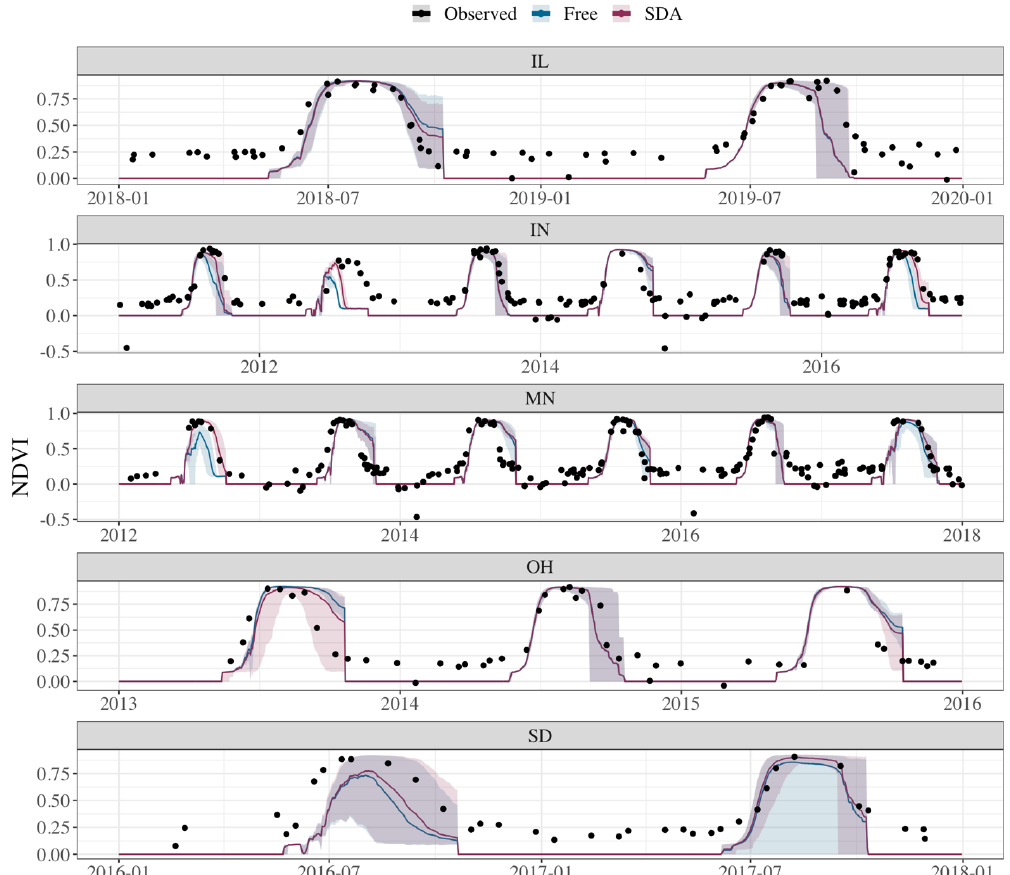
Figure A2. Time series of NDVI estimates from the two schemes for each site year with the mean daily estimates demonstrated with line graphs and the 95% credibility interval demonstrated by the shaded regions. Black points represent the observed